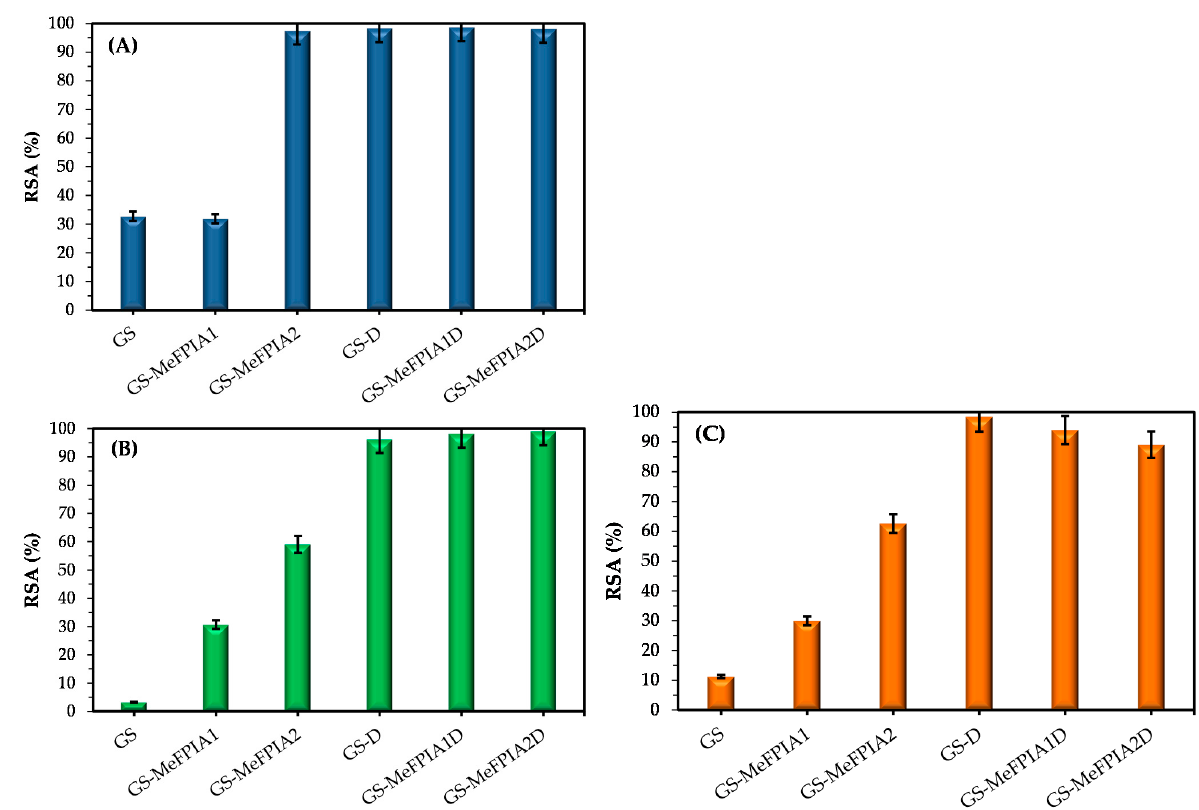
Figure 6. Antioxidant activity of gelatin-based films by the 2,2 ′ -azino-bis(3-ethylbenzothiazoline-6-sulfonic acid) (ABTS) method after 30 min in ( A ) in water, ( B ) in ethanol/water 50/50, and ( C ) in ethanol/water 95/5. RSA, radical scavenging activity.